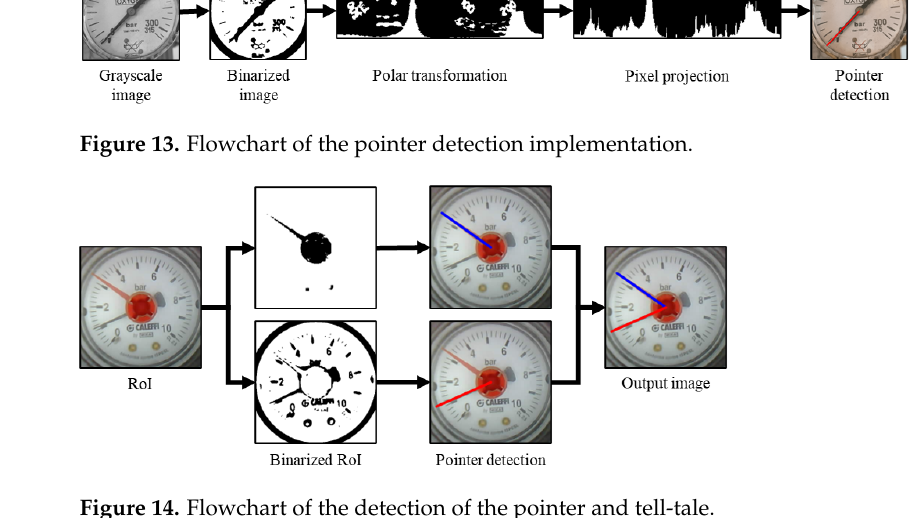
Figure 14. Flowchart of the detection of the pointer and